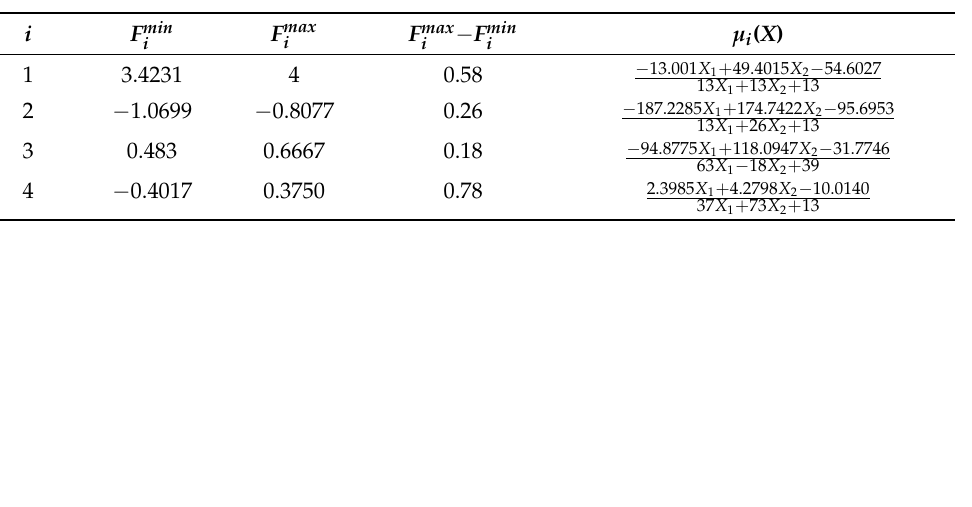
Table 3. Maxima and minima of F i ( X ) over feasible region S and the membership functions for